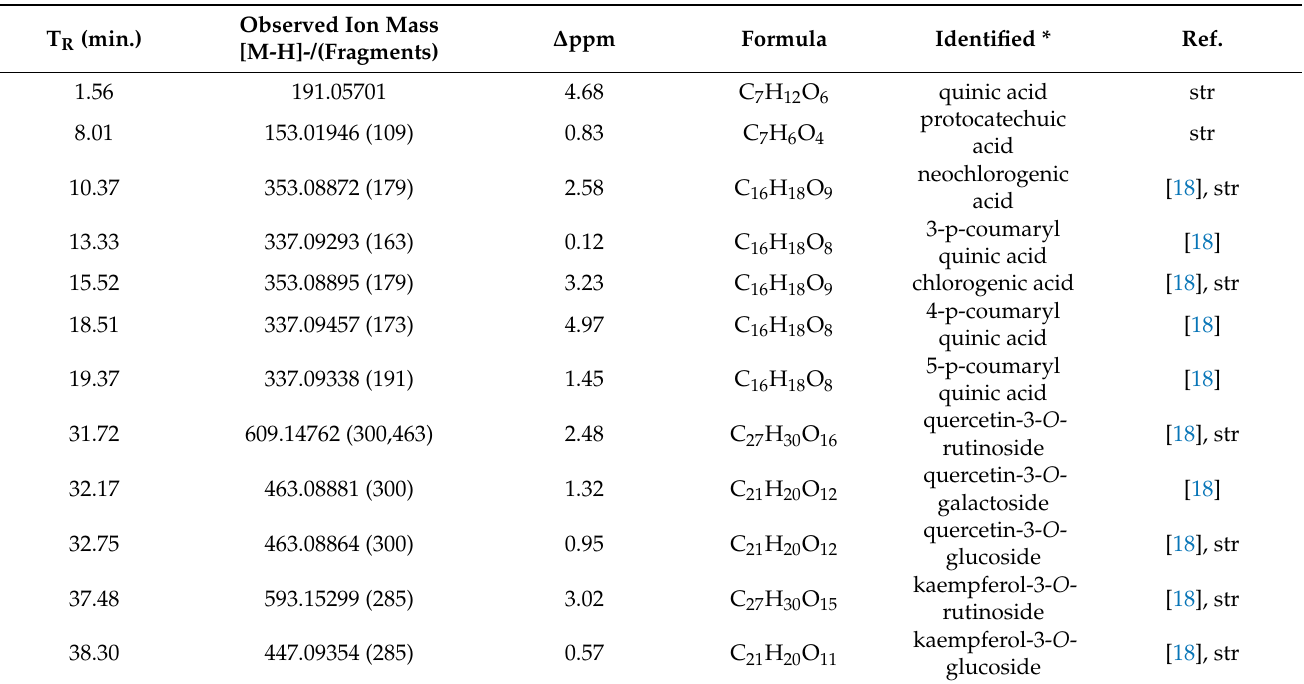
Table 1. MS data of polyphenolic components identified in S. chinensis fruits extract at negative ionization mode.